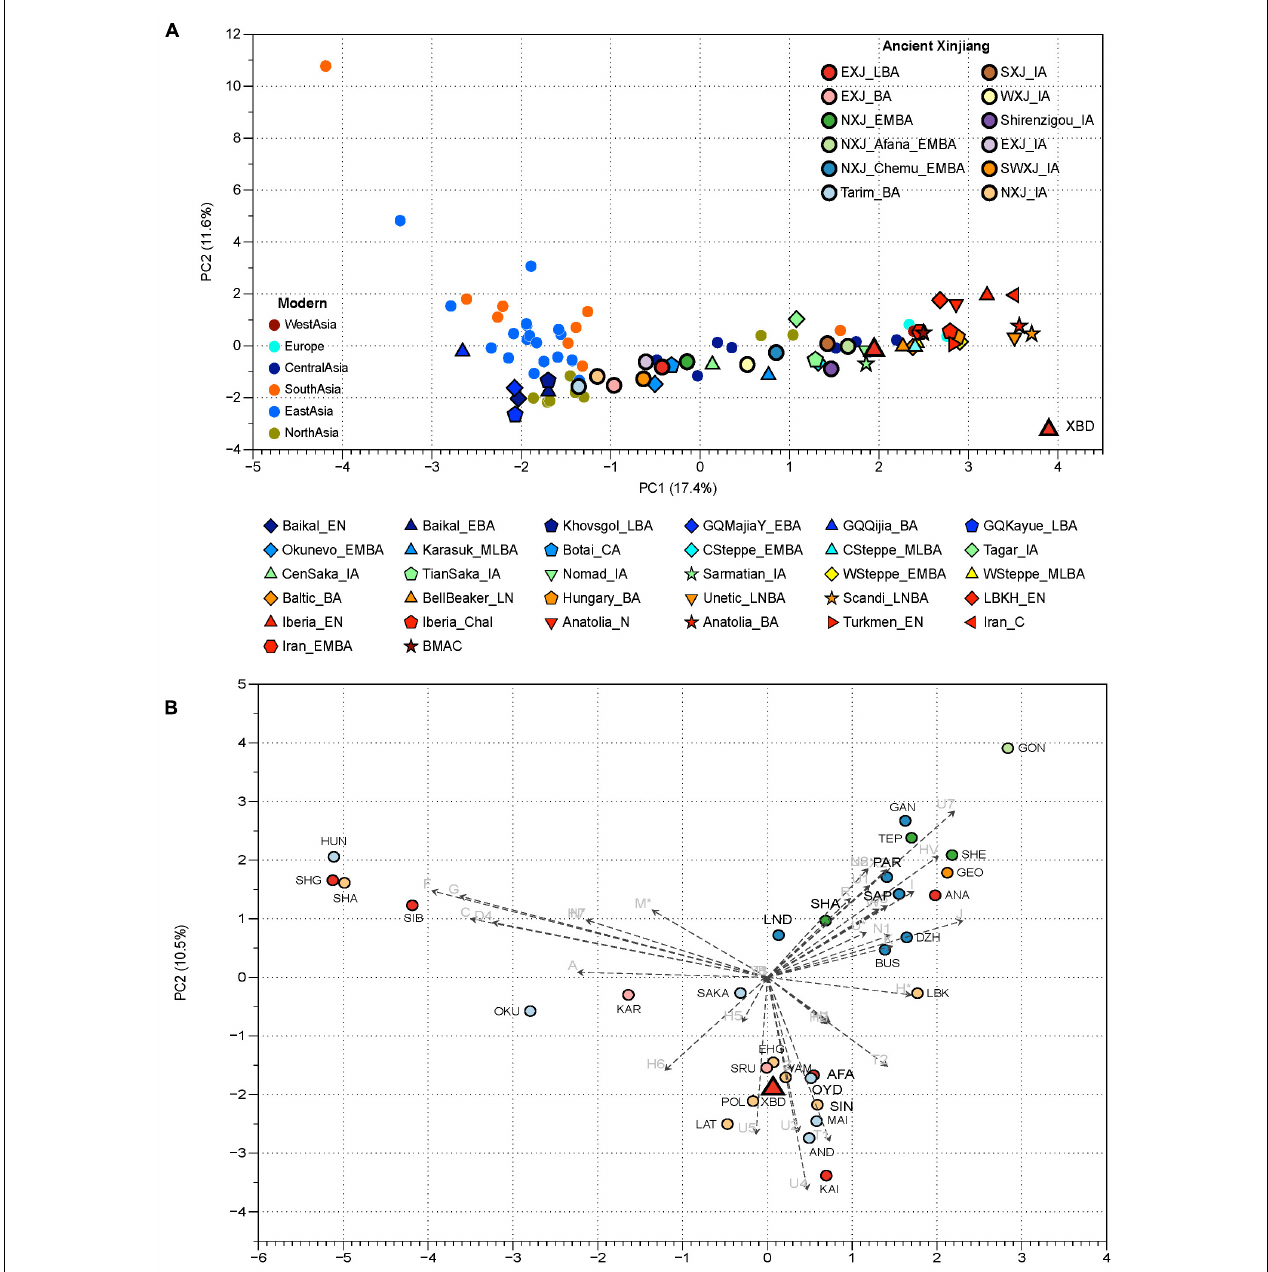
FIGURE 2 | Principal component analysis (PCA) based on mitochondrial DNA (mtDNA) haplogroup frequencies of ancient and present-day Eurasian populations. (A) The PCA constructed by populations from Xinjiang and neighboring regions. The different combinations of color and scheme on the plot represent different groups, present-day populations are marked with a circle; circles with dark black frames represent the published ancient Xinjiang samples, while shapes with light black frames are published ancient populations from the Eurasian continent. The single red triangle is the XBD populations in our study. NXJ, northern Xinjiang; EXJ, eastern Xinjiang; SXJ, southern Xinjiang; SWXJ, southwestern Xinjiang; WXJ, western Xinjiang. Detailed descriptions and references of comparative populations are provided in Supplementary Tables 1B, C . (B) The PCA constructed on ancient populations from the Eurasian continent. The two dimensions account for 25.8% of the total variance. Haplogroup contributions are represented by loading vectors marked as grep arrows. Population abbreviations are as follows: XBD, Xiabandi; SMK, Shamanka_EBA; ESHG, Scandinavian hunter-gatherers; ANA, Anatolia_N; LAT, Mesolithic/Neolithic Hunter gatherers from Lativ; LBK, LBK_EN; SIB, ancient Siberians; AFA, Afanasievo; KAI, Kairan_MLBA; AND, Andronovo; HUN, Tianshan_Hun; SAK, Tianshan_Saka; MAI, Maitan_MLBA; OKU, Okunevo; OYD, Oy_Dzhaylau_MLBA; POL, Poltavka; SIN, Sintashta; SRU, Srubnaya; YAM, Yamnaya; KAR, Karasuk; BUS, Bustan_BA; DZH, Dzharkutan_BA;